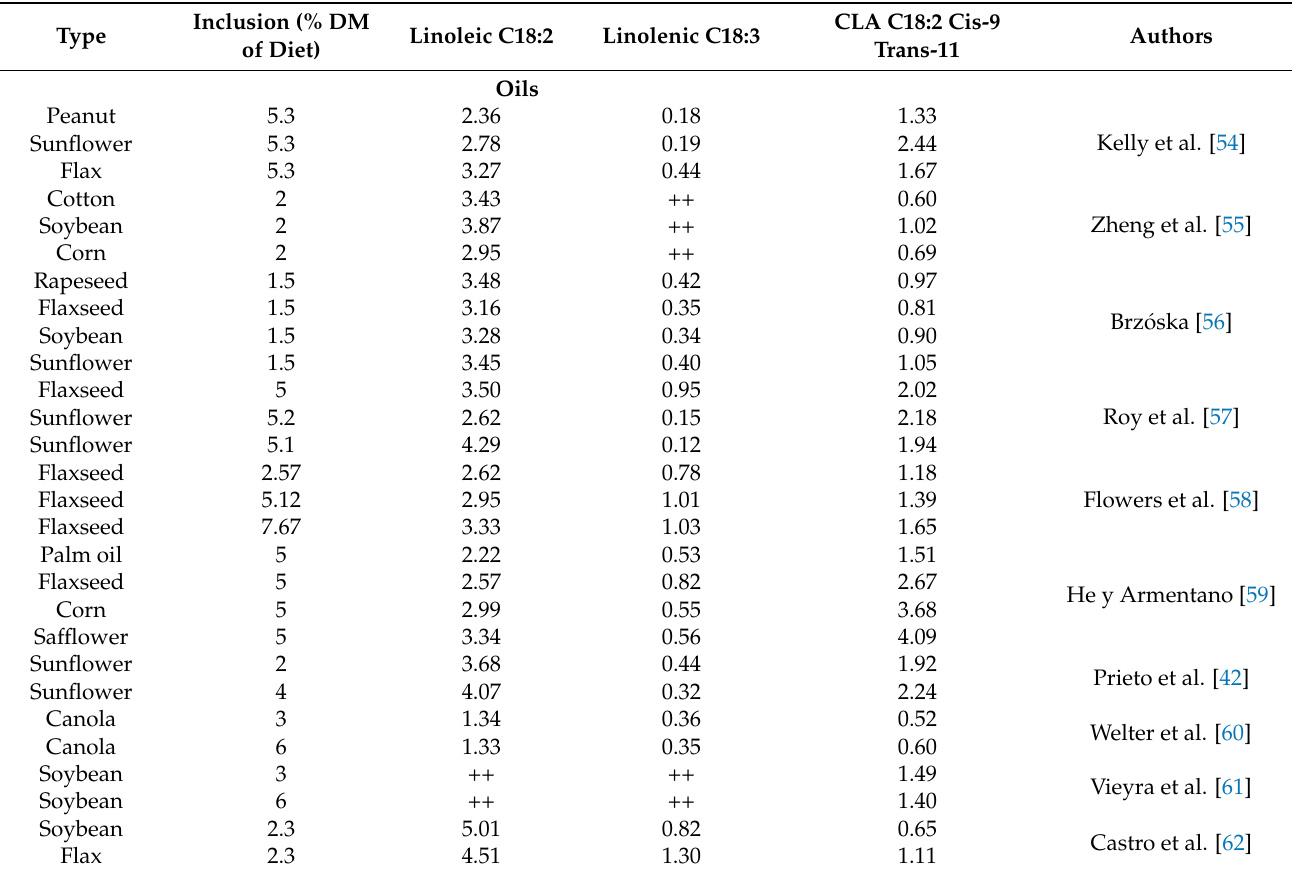
Table 2. Contents of linoleic C18:2, linolenic C18:3, and CLA FA in milk (g/100 g of fat) using different types of oils in the feeding of dairy